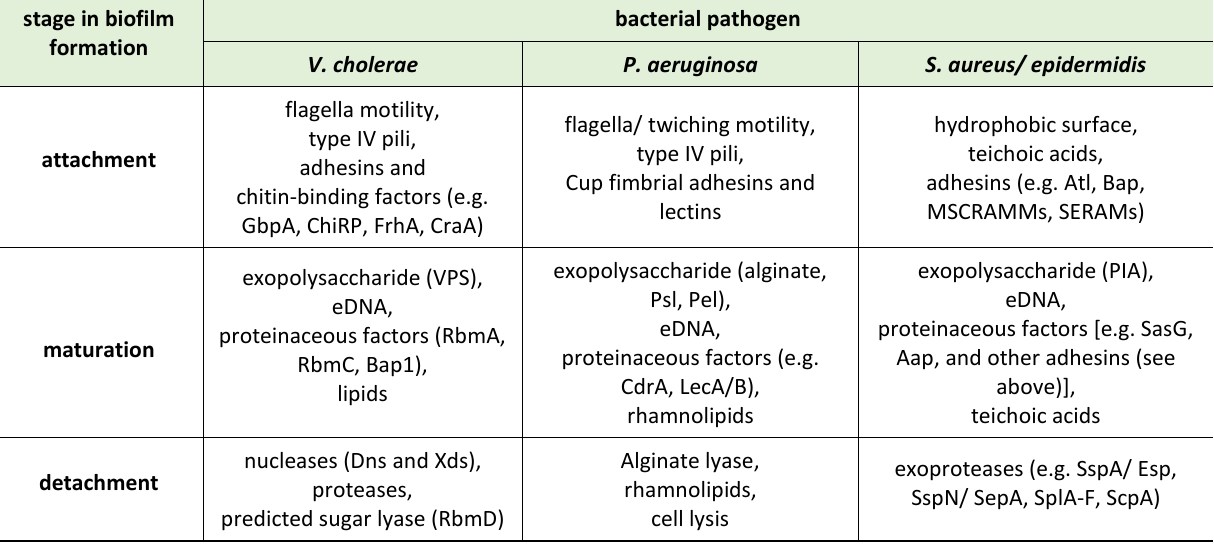
TABLE 1. Overview of factors involved in the different stages of biofilm formation for the bacterial pathogens V. cholerae , P. aerugino- sa , S. aureus and S. epidermidis discussed in this article. For details we kindly refer to the text (see chapter “Bacterial biofilm formation and